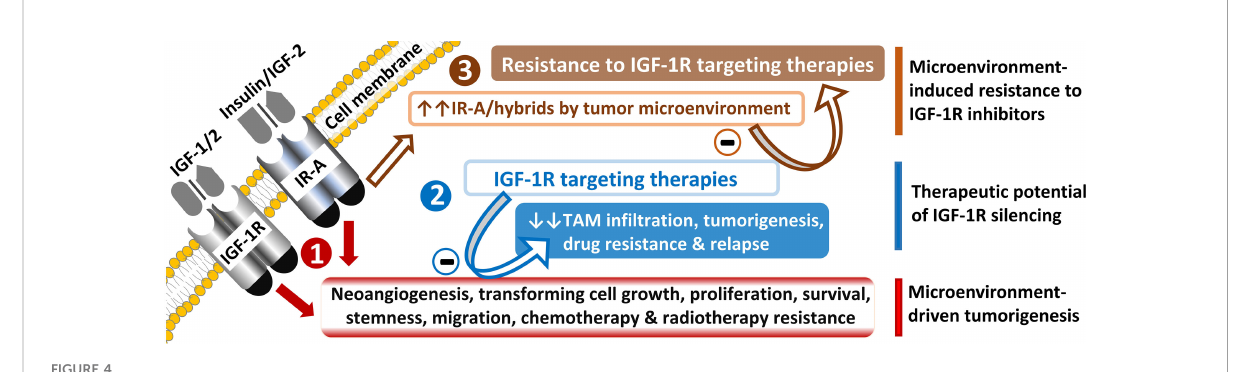
FIGURE 4 Potential and a challenge of IR-A/IGF-1R targeting in